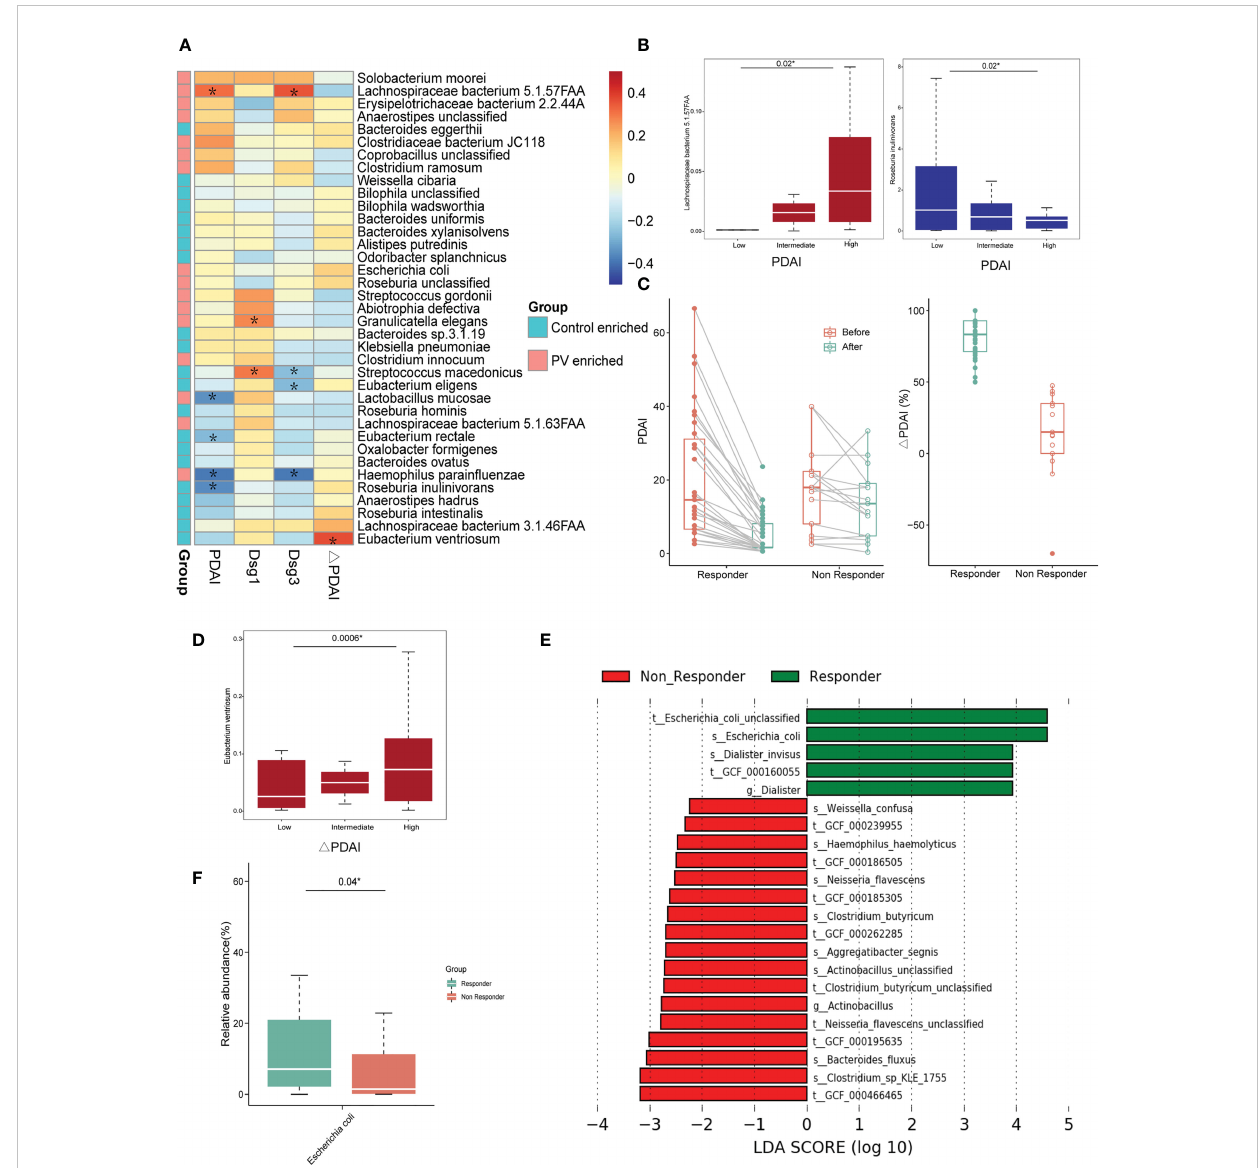
FIGURE 2 The correlation between differential microbial species and clinical indexes. (A) Heatmap of correlation coef fi cients between differential microbial species and PDAI, anti-Dsg1 antibody titers, anti-Dsg3 antibody titers, and D PDAI; The *means the P value is less than 0.05 using Spearman ’ s correlation analysis; (B) Positive correlation between PV-enriched gut microbiome and PDAI scores and negative correlation between the healthy control-enriched gut microbiome and PDAI scores (*represents statistical signi fi cance with the P value <0.05 using Kruskal-Wallis test); (C) The graph on the left shows the change in PDAI scores before and after treatments in the responder and non-responder groups; The graph on the right shows the D PDAI for the responder and non-responder groups; (D) The positive correlation between the relative abundance of Eubacterium ventriosum and D PDAI (*represents statistical signi fi cance with the P value <0.05 using Kruskal-Wallis test); (E – G) Results of differential bacteria between the responder and non-responder groups by LEFse analysis; (F) Boxplots of the relative abundance of Escherichia coli in the responder and non-responder groups (*represents statistical signi fi cance with the P value <0.05 using Wilcoxon sum-rank test). PV, pemphigus vulgaris; PDAI, pemphigus disease area index; Dsg: desmoglein; D PDAI: PDAI improvement rates; LEFse, LDA effect size analysis; LDA, linear discriminant